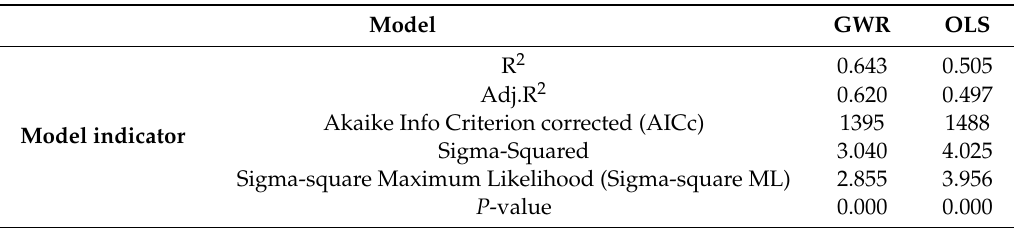
Table 3. The model indicator di ff erence between Geographic Weighted Regression (GWR) and OLS at prefectural